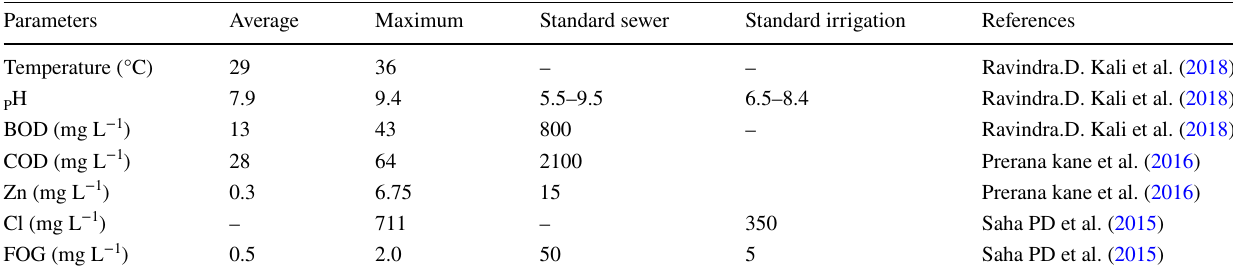
BOD biological oxygen demand; COD chemical oxygen demand; FOG fats, oils and